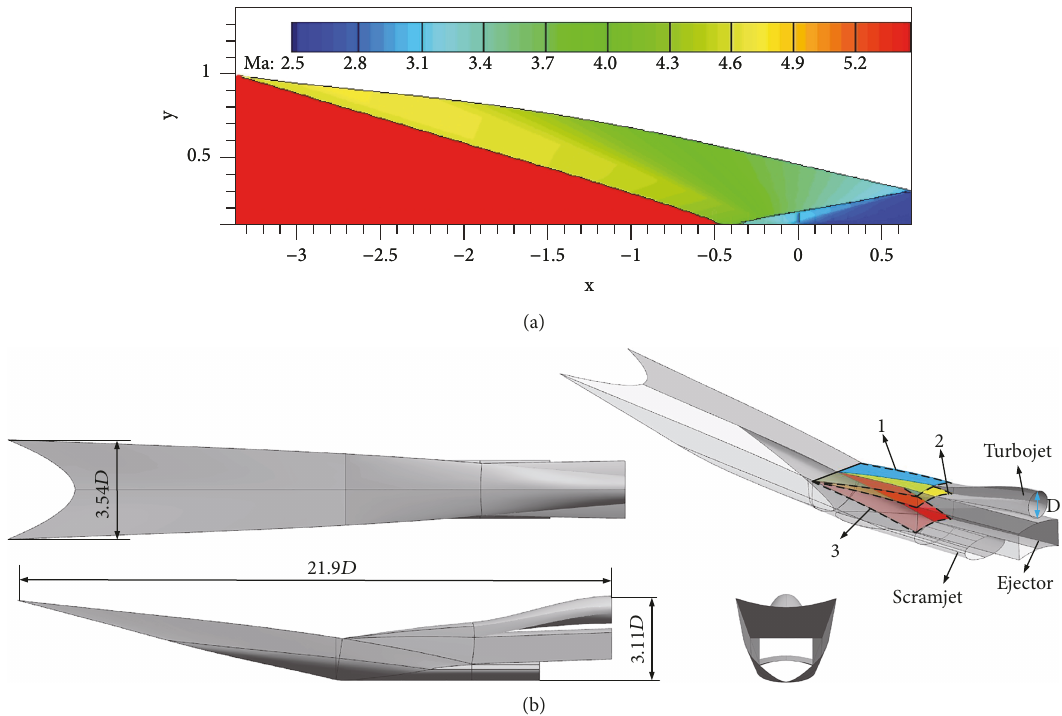
Figure 1: (a) Mach number distribution of the basic ICFD fl ow fi eld. (b) Geometry of the tri-duct inward-turning